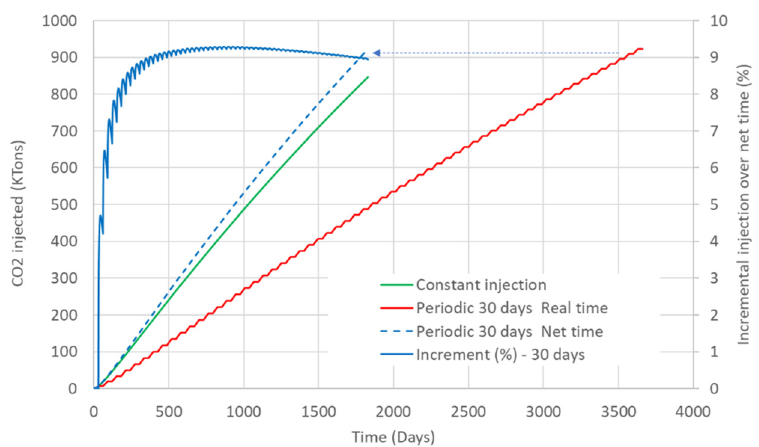
Figure 14. Up-flank injection with one month period half-length. The periodic injection shows around 9% more CO 2 injected after 2 years net injection time compared to continuous injection.